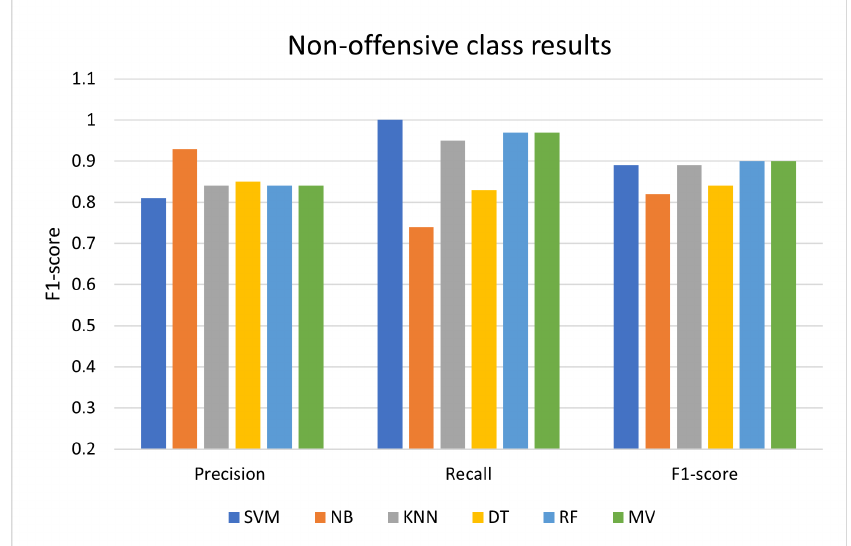
Figure 4. Non-offensive class results for original imbalanced